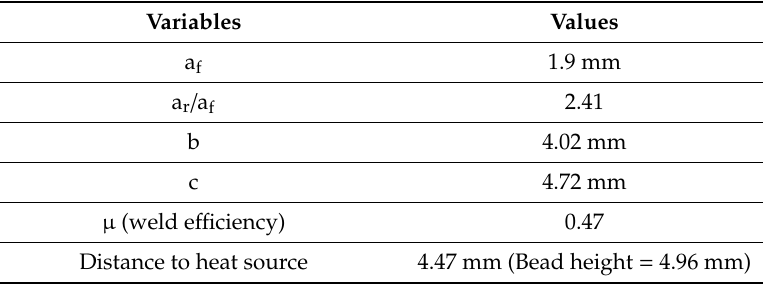
Figure 12. Temperature distribution of FEM. Table 8. Results of optimization.